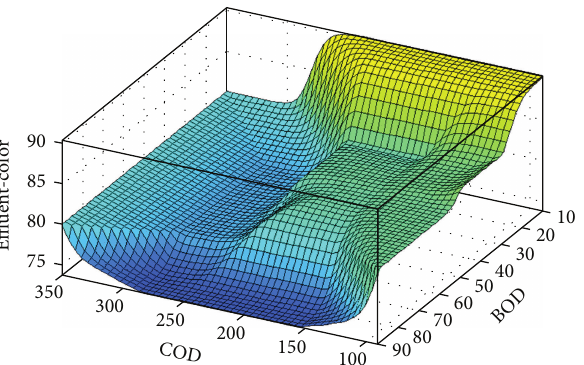
was found to be 0.96, 0.97, and 0.92 for COD, BOD, and color, respectively. Multiple linear regressions suggested that the color removal rate is more dependent on the effluent